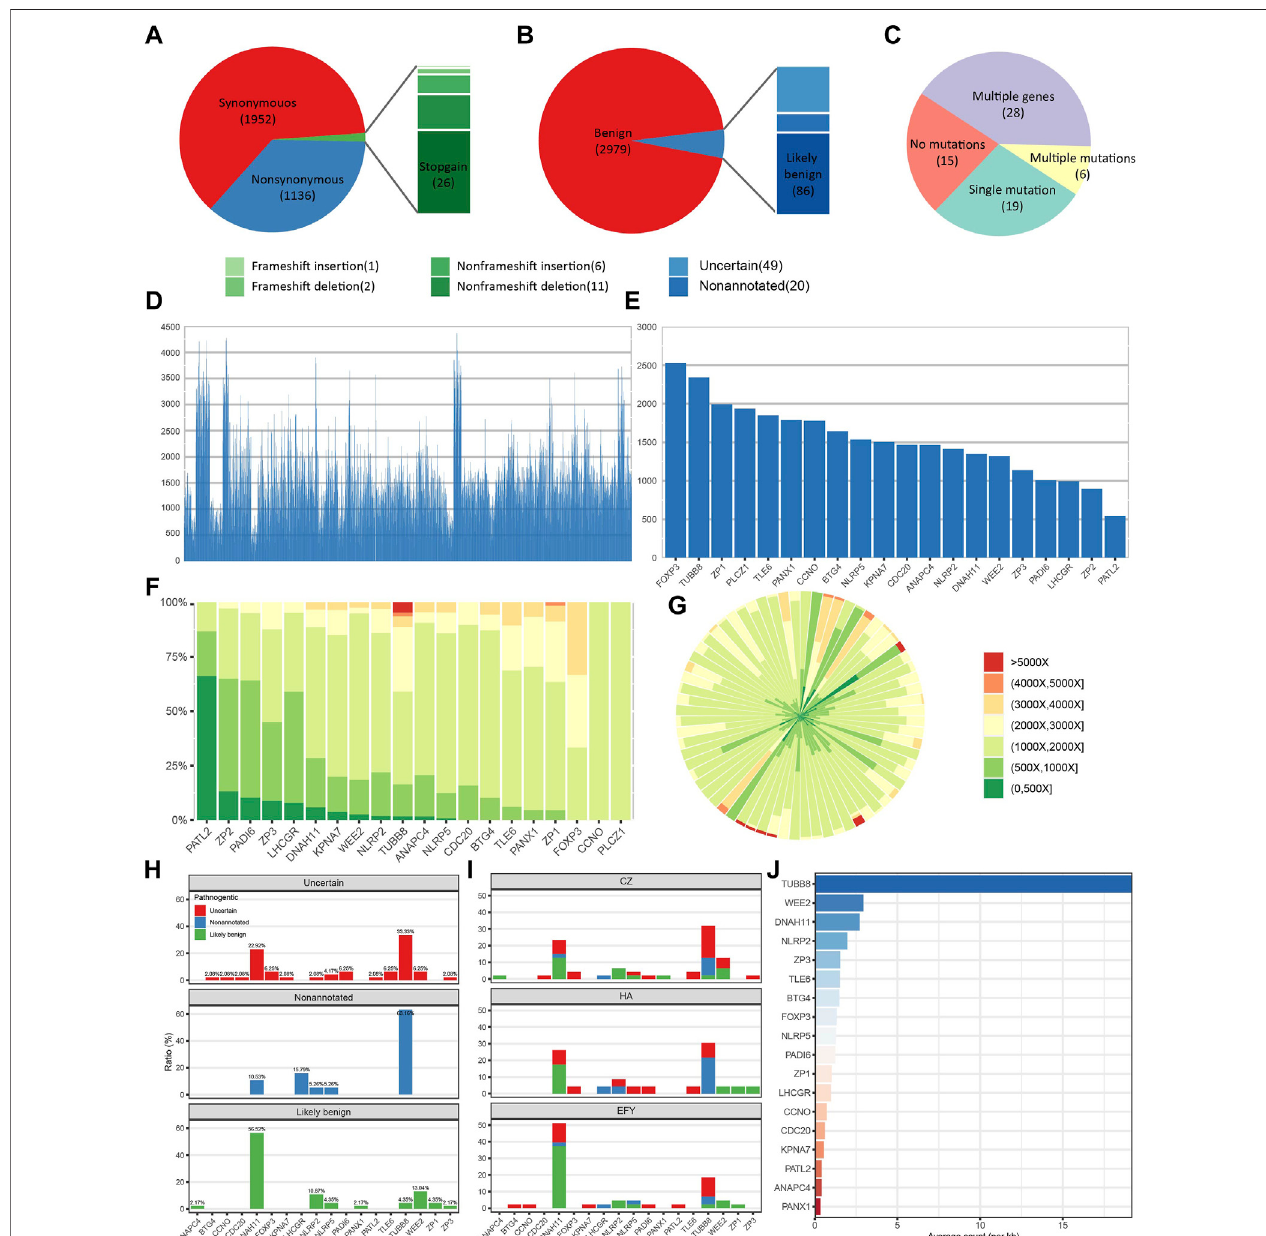
FIGURE 2 | Panel sequencing performance. (A) The proportions of different types of variants. (B) The proportions of variants with different annotations. (C) The distributionofpatientswithdifferentamountsofpotentiallysigni fi cantvariants. (D) Sequencingdepthofalldetectedexonicandsplicingvariants. (E) Averagesequencing depthofeachgene. (F) Sequencingdepthdistributionofvariantsoneachgene. (G) Sequencingdepthdistributionofeachpatient. (H) Annotationdistributionsofallnon- synonymous and non-benign variants on each gene. (I) Distributions of all non-synonymous and non-benign variants on each gene from three different reproductive centers. CZ means Heping Hospital af fi liated to Changzhi Medical College. HA means the af fi liated Huaian No. 1 People ’ s Hospital of Nanjing Medical University, and EFY means Reproductive Medical Center of the Second Af fi liated Hospital of Nanjing Medical University. (J) Normalized variants distribution on each